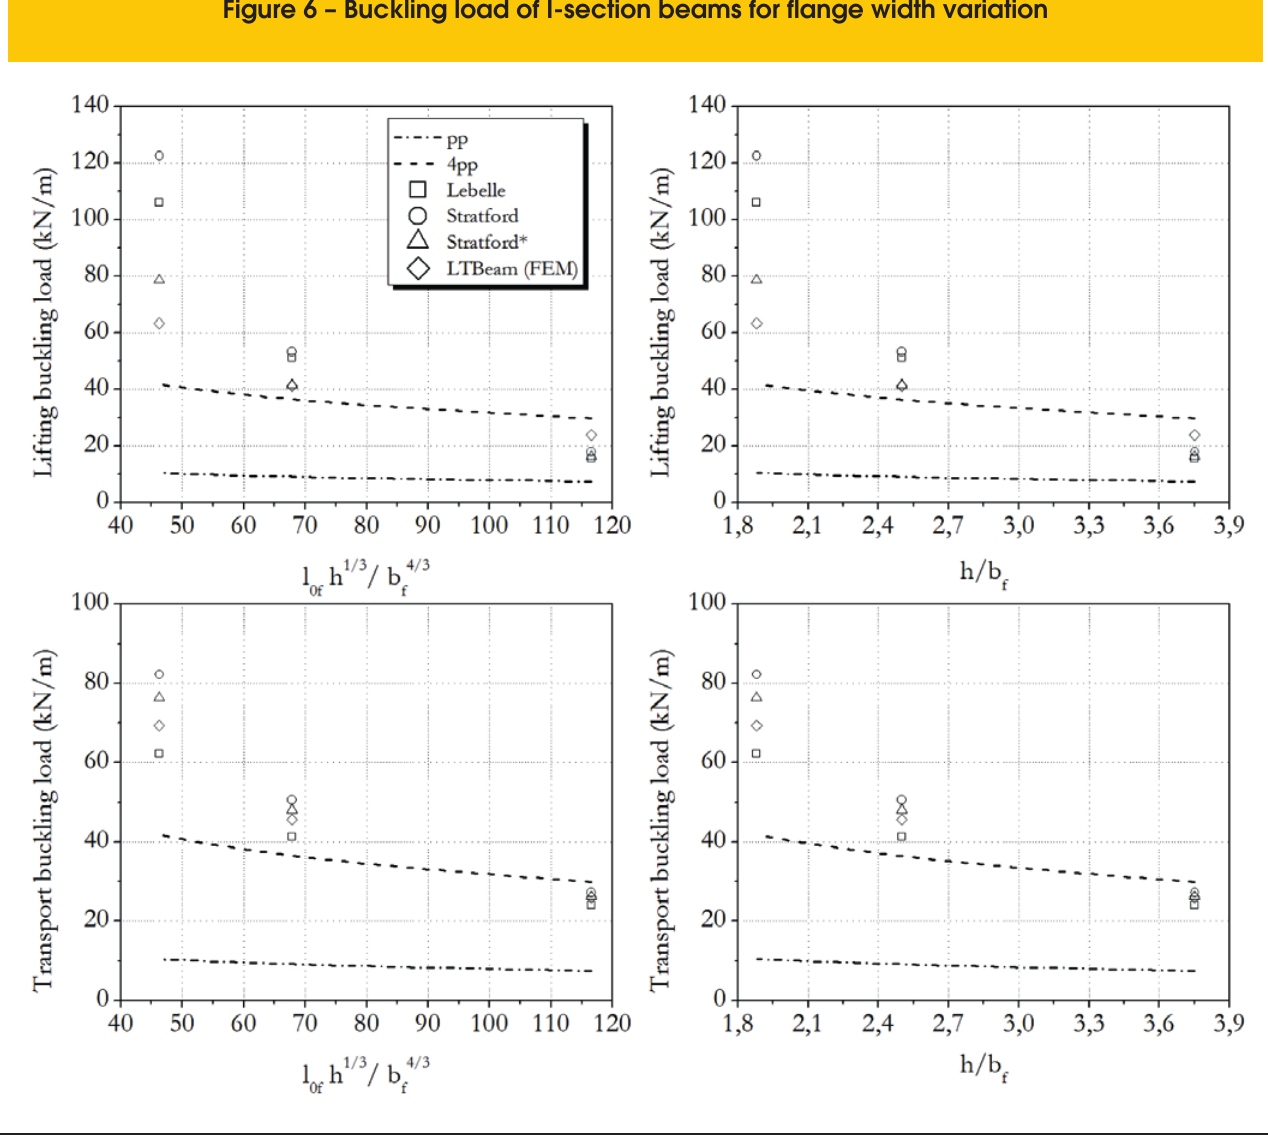
Figure 6 – Buckling load of I-section beams for flange width